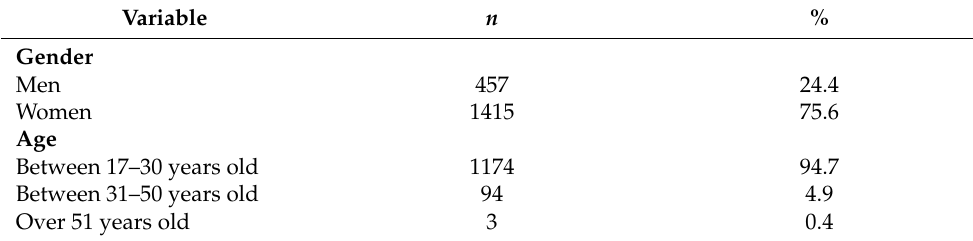
Table 1. Gender and